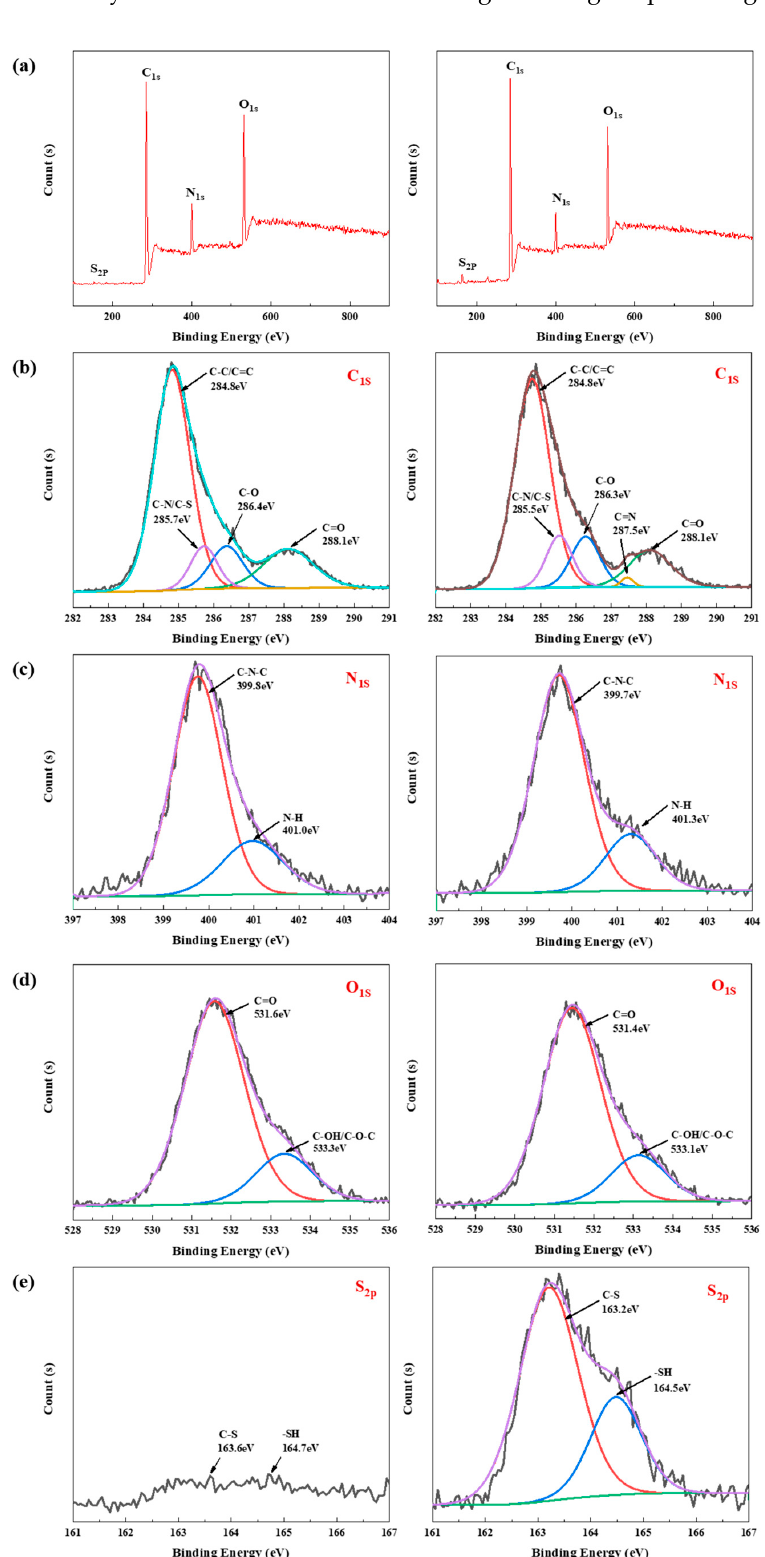
Figure 2. ( a ) XPS survey spectra of PPI-CDs and N, S-PPI-CDs; high-resolution XPS spectra of ( b ) C1s, ( c ) N1s, ( d ) O1s and ( e ) S2p of PPI-CDs and N, S-PPI-CDs, respectively.